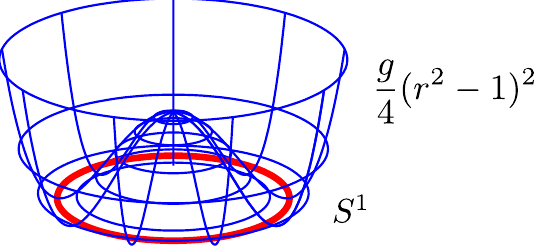
Figure 2 . Potential in the deformed theory. The original theory on S 1 lies at the bottom of the potential, and the original theory is recovered in the g → ∞